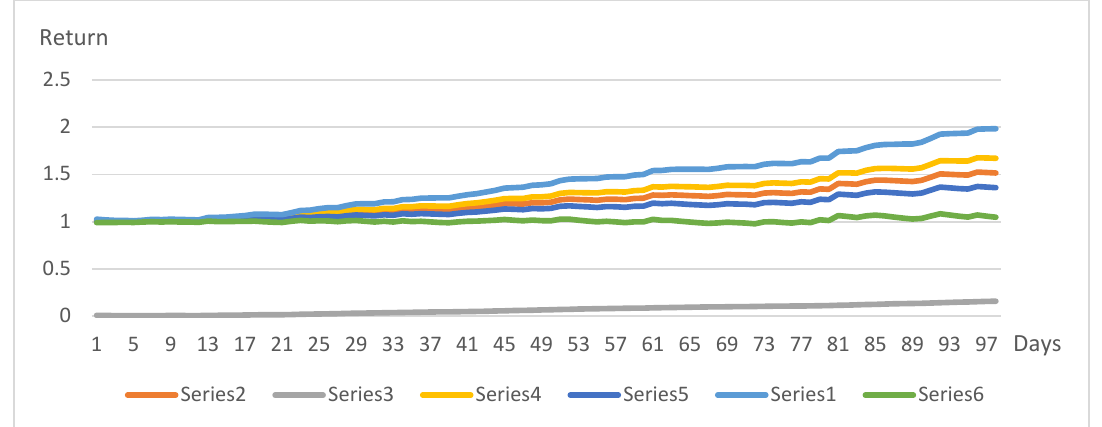
Figure 9. Confidence intervals of return on 7 stocks’ portfolio (German market) (source: compiled by the authors based on Yahoo Finance data and own calculations).